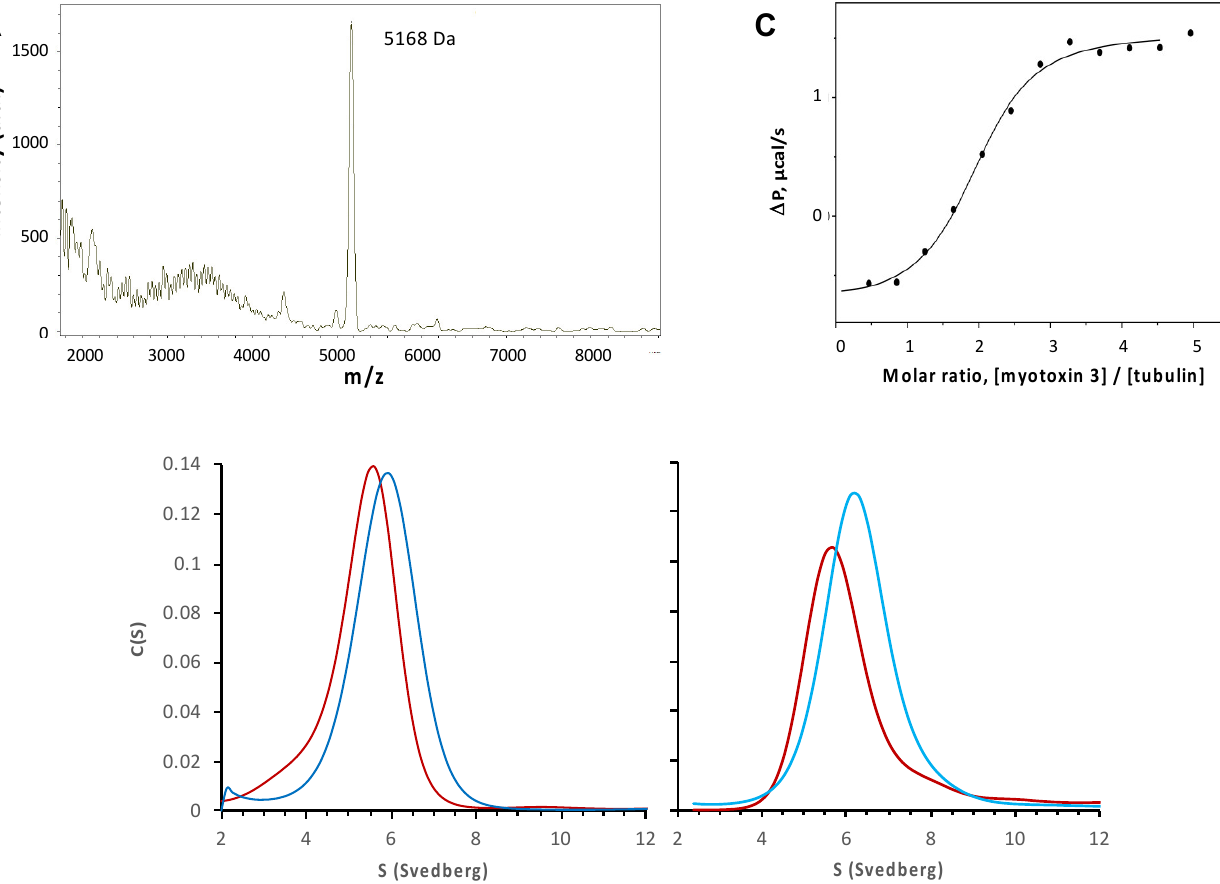
Figure 10. Binding of myotoxin-3 to microtubules and ab-tubulin dimers. ( A ) MALDI MS spectrum of peptides co-sedimented with microtubules. ( B ) Sedimentation profiles were obtained by analytical ultracentrifugation of tubulin alone (red) or tubulin with 45-residue myotoxin-3 (dark blue, left panel) or 43-residue myotoxins 3 (light blue, right panel). ( C ) The fitting curve of experimental data from titration of 55 µM tubulin by 2.2 mM of myotoxin-3 obtained by ITC. Data shown are from a representative experiment of two ( B ) or three ( A , C ) performed.